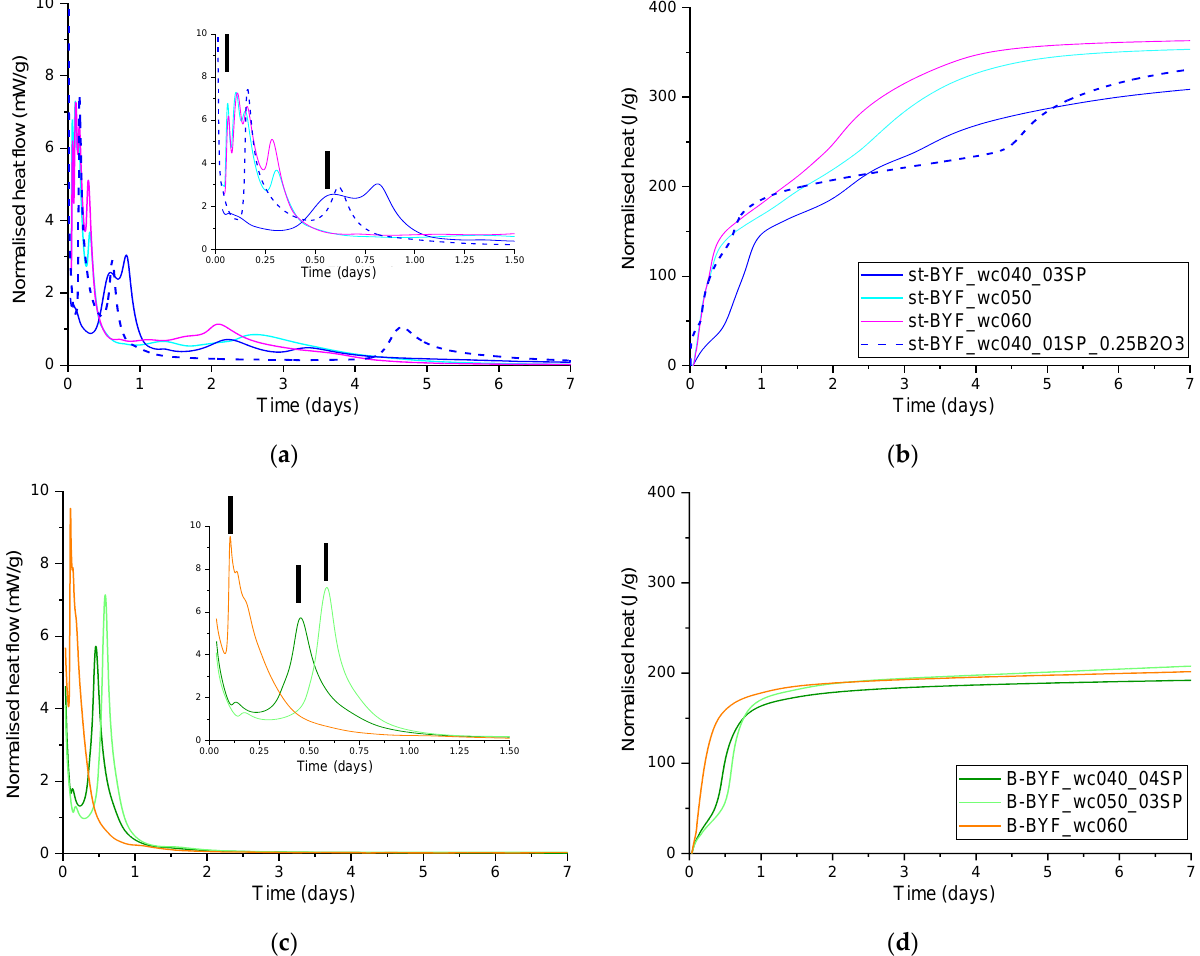
Figure 4. Calorimetric curves for ( a ) and ( b ) st-BYF and ( c ) and ( d ) B-BYF, with different w/c ratios. Vertical bars in ( a ) and ( c ) indicate the heat evolved due to the precipitation of AFt.